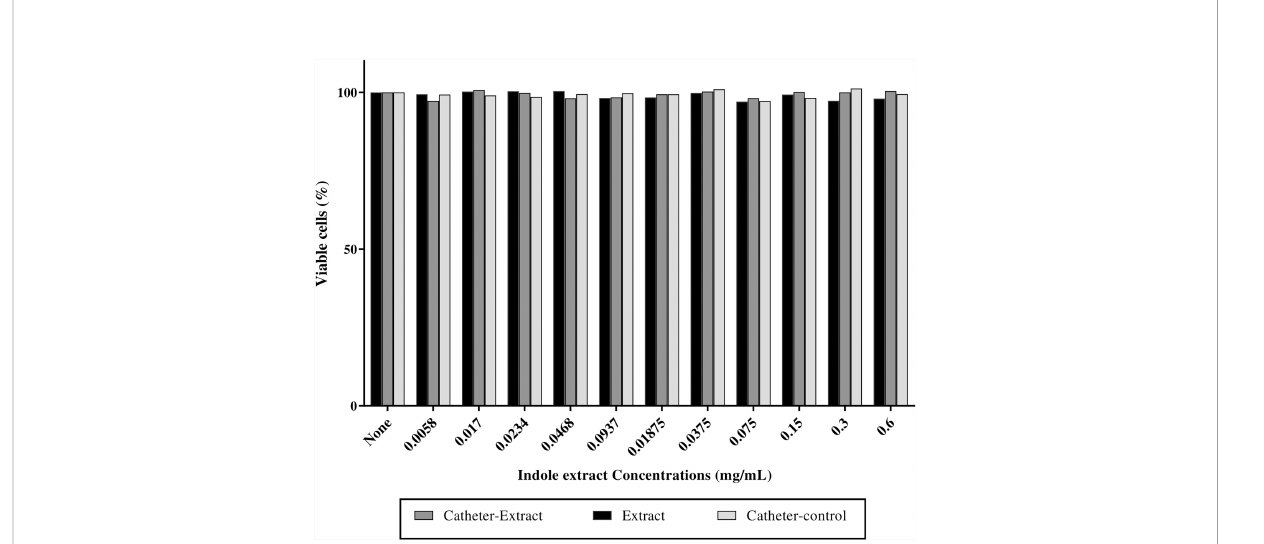
FIGURE 5 Indole extract showed no cyctotoxic effect on fi broblast cells. Cytotoxicity assay on human fi broblast cells after 24 h exposure to the nutrient medium interacting with indole extract (0.6 mg/mL), impregnated catheter with extract (0.6 mg/mL) and control catheters on human fi broblast cells. Cytotoxicity was determined by MTT assay and represented as the percentage of remaining viable cells after treatment.